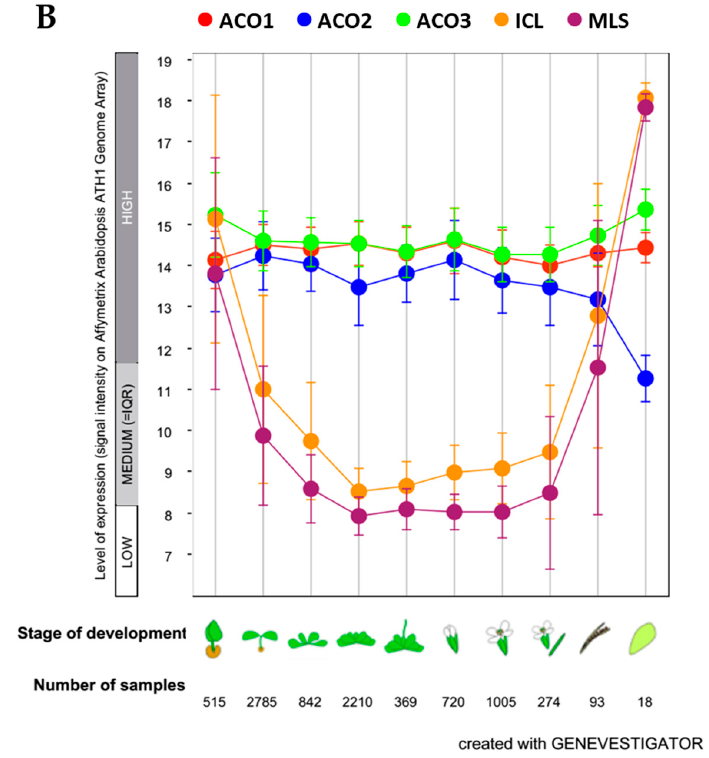
Figure 3. Expression of Arabidopsis genes plotted with Genevestigator (https://genevestigator.com) on Affymetrix Arabidopsis ATH1 Genome Array data. ( A ) Data expressed in a color coding scaled to the expression potential ( = the maximum expression a gene reaches across all experiments); ACO1: aconitase 1 (At4g35830); ACO2: aconitase 2 (At4g26970); ACO3: aconitase 3 (At2g05710); ICL: